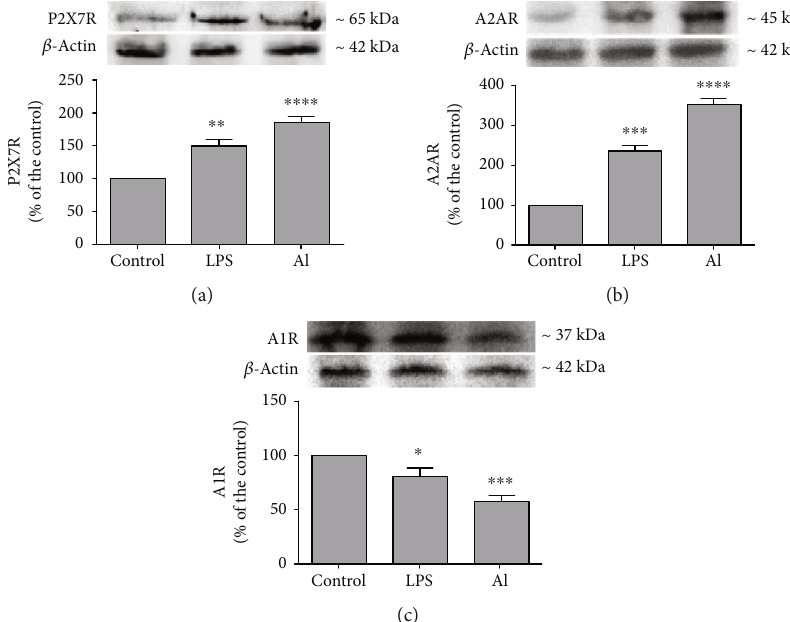
Figure 4: Protein density of purinoceptors by Western blot analysis of microglial cells treated with LPS (1 μ g/mL) and AlCl 96h. Al =aluminum; LPS =lipopolysaccharide. Values are expressed as mean ± SD ( n = 3 ). ∗ Statistical signi fi cance in comparison to the control group. ∗ p < 0 : 05 , ∗∗ p < 0 : 01 , ∗∗∗ p < 0 : 001 , and ∗∗∗∗ p < 0 : 001 . One-way ANOVA followed by Tukey ’ s post hoc